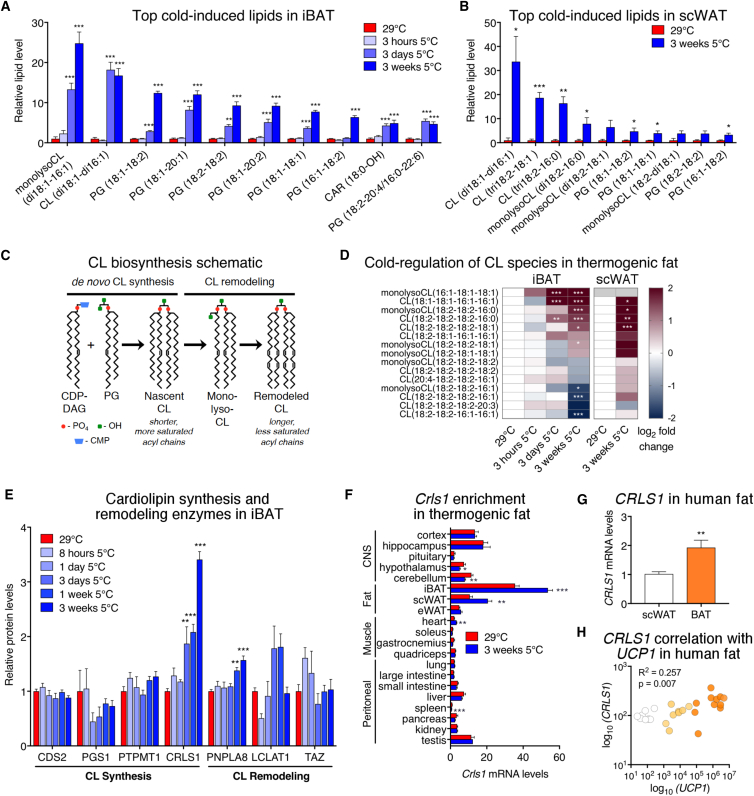
Cardiolipins Are Robustly Increased in Activated Brown and Beige Fat(A) Ten most cold-induced lipids from lipidomic analysis of iBAT from mice housed at thermoneutrality or exposed to 5°C cold for 3 hr, 3 days, or 3 weeks (fold change relative to thermoneutral, 29°C = 1; n = 4 per group, one-way ANOVA).(B) Top ten cold-induced lipids from lipidomic analysis of scWAT from mice housed at thermoneutrality or exposed to 5°C cold for 3 weeks (fold change of absolute quantities normalized to protein content, 29°C = 1; n = 4 per group, t test). CL, cardiolipin; PG, phosphatidylglycerol; CAR, acyl carnitine.(C) Schematic of cardiolipin synthesis and remodeling; CDP-DAG, cytidine diphosphate diacylglycerol; CMP, cytidine monophosphate.(D) Heatmaps of log2 (fold change cold treated/thermoneutrality) for CL species in iBAT and scWAT (n = 4 per group, one-way ANOVAs for iBAT and t tests for scWAT; gray, not detected).(E) Relative iBAT protein levels of cardiolipin de novo synthesis and remodeling pathway enzymes from proteomic analysis presented in Figure 1A (n = 4 for 29°C and 5°C 3 weeks, n = 3 for other groups; one-way ANOVA).(F) Tissue distribution of Crls1 from mice housed at thermoneutrality or cold exposed for 3 weeks (n = 6 per group; t test).(G and H) (G) CRLS1 levels in human subcutaneous fat (n = 8) and brown fat with high UCP1 mRNA expression (n = 11, UCP1 CT values between 19 and 27; t test) and (H) correlation with UCP1 in scWAT (n = 8; white), low-UCP1 BAT (n = 8, UCP1 CT values between 27 and 37; yellow), and high-UCP1 BAT (n = 11; orange; Pearson R2 and p value shown). Data are presented as means ±SEM. ∗p < 0.05; ∗∗p < 0.01; ∗∗∗p < 0.001.See also Figure S2.